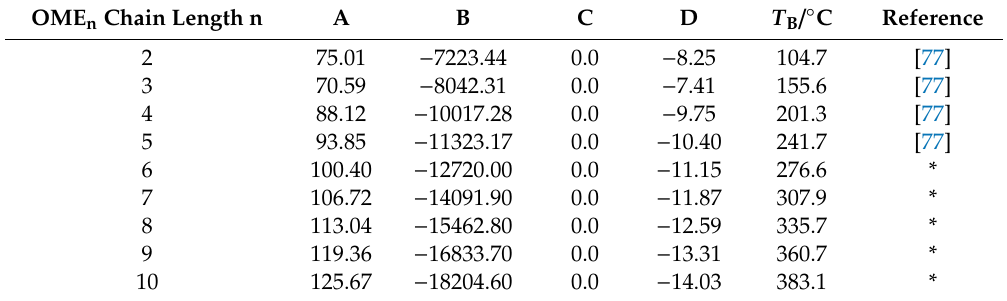
Table 5. Correlation parameters of vapor pressure equation (Equation (8)) and the normal boiling points of OME n .